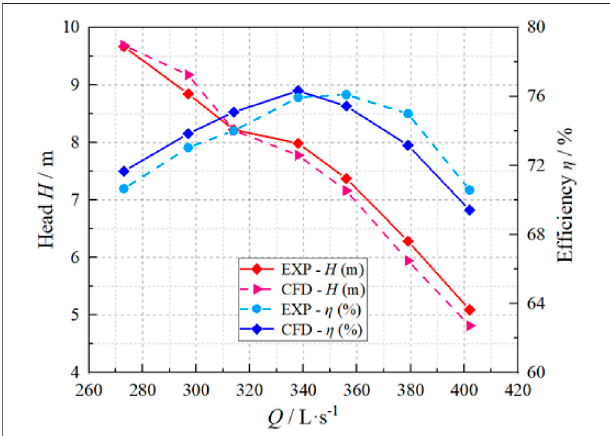
FIGURE 5 | Comparison of model test and numerical simulation results.